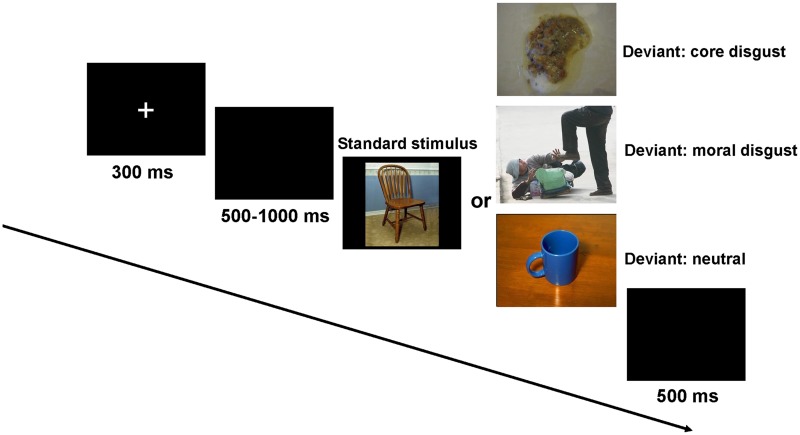
The schematic illustration of the experimental procedure.Core disgust: vomit. Moral disgust: a bad antisocial action, a person stamping on a disabled beggar. Picture presentation was terminated by a key pressing or when 1000 ms was elapsed.